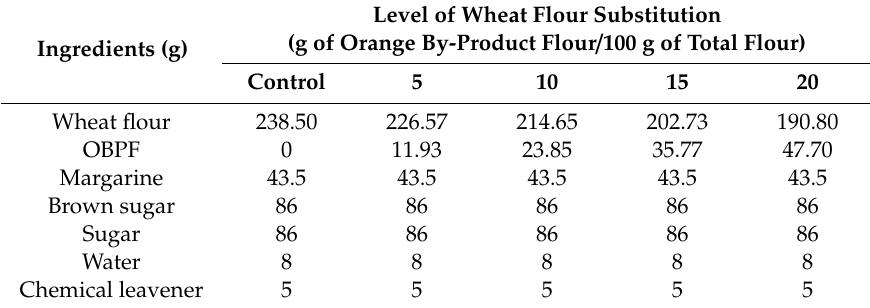
Table 1. Cookie dough composition for di ff erent levels of wheat flour substitution with orange by-product flour